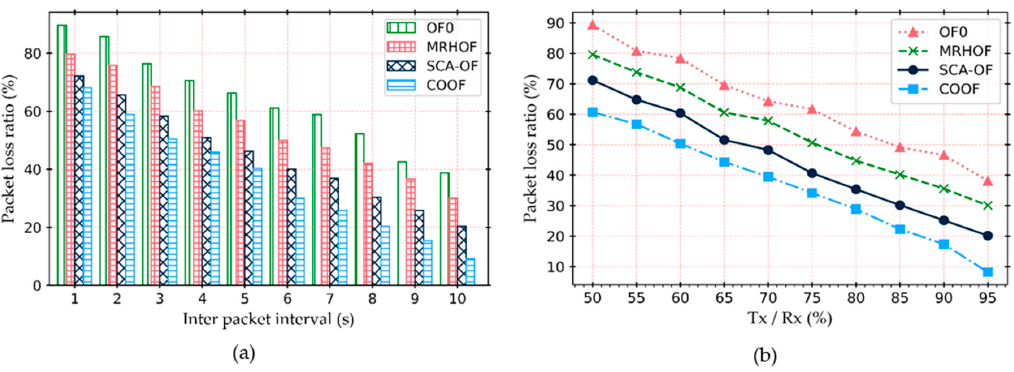
Figure 11. Packet losses in the queue; ( a ) packet loss ratio in terms of different inter packet arrival interval, ( b ) packet loss ratio with respect to the transmit and receive success ratio.